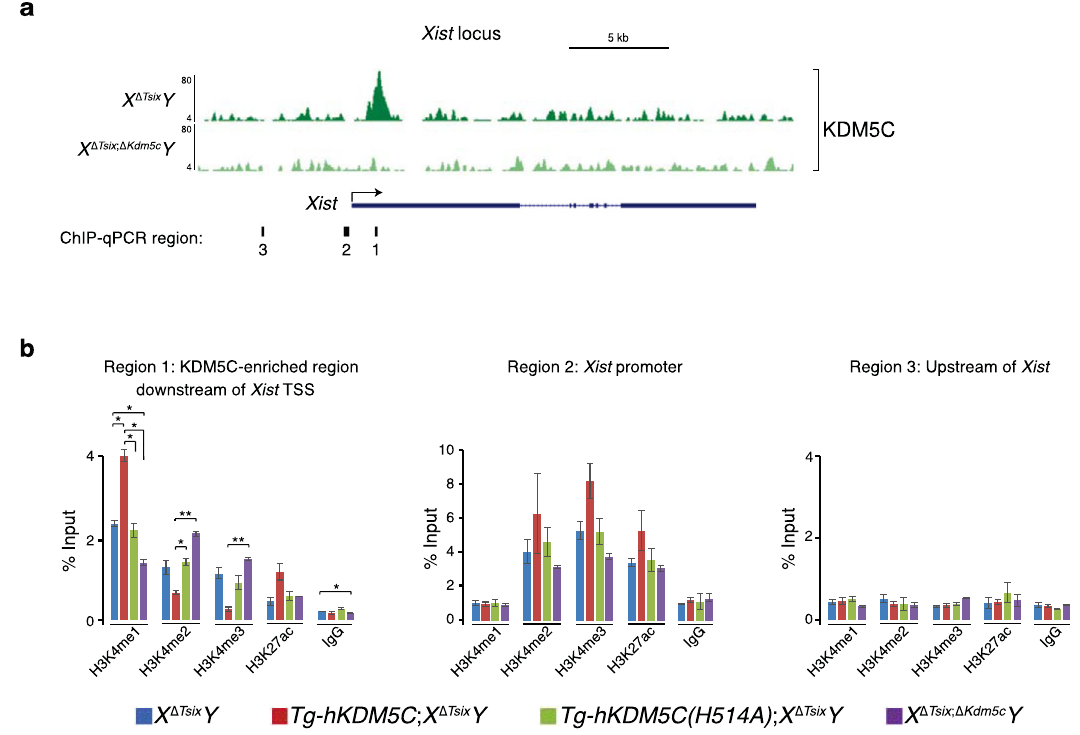
Fig. 5 KDM5C upregulation of Xist expression via putative enhancer activation. a KDM5C enrichment at the Xist locus detected by ChIP-Seq. See Supplementary Table 7 for ChIP-seq read quanti fi cation. b ChIP-qPCR quanti fi cation of H3K4me1, H3K4me2, H3K4me3, and H3K27ac enrichment at the Xist locus. Locations of PCR amplicons are denoted beneath the browser views in ( a ). ChIPs were performed on day 2 differentiated EpiLCs generated from two independent ESC lines/genotype. qPCRs were performed in triplicate for each ChIP sample. Data are presented as mean ± SEM between ChIP replicates. Selected pairwise comparisons are shown. * P ≤ 0.05; ** P < 0.01; *** P < 0.001, Welch ’ s two-sided t tests. See Supplementary Table 8 for all pairwise statistical comparisons. Source data are provided as a Source Data fi